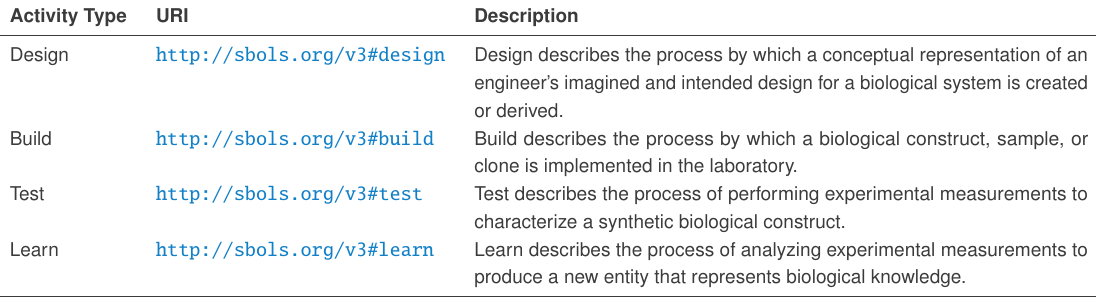
Table 19: Synthetic biology workflow